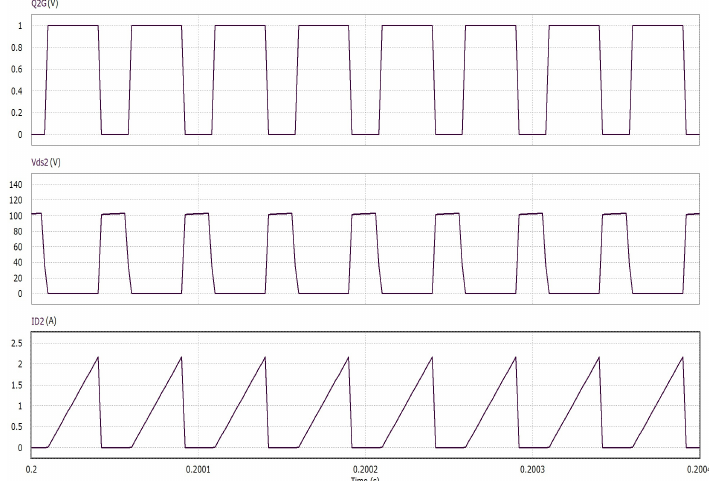
Figure 17. PSIM simulation of switch stresses of